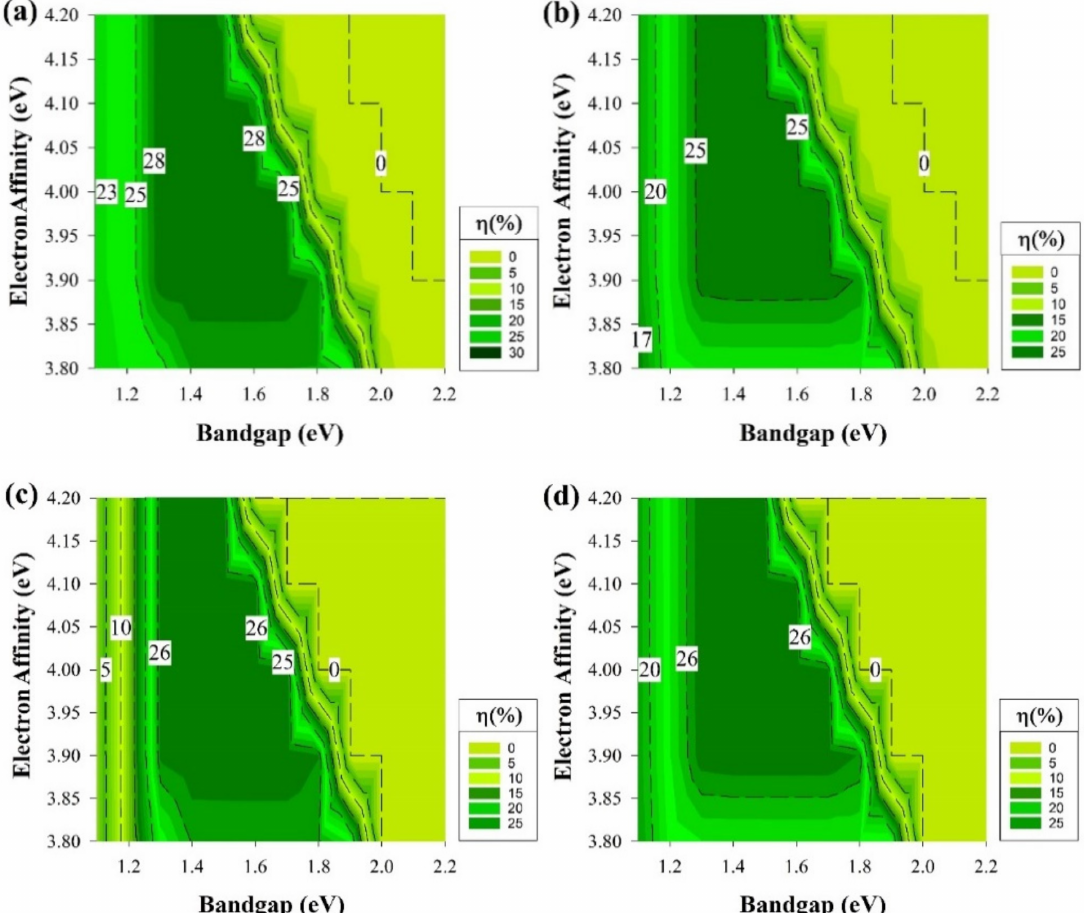
Figure 3. The efficiency of four proposed structures as a function of E g and χ for all passivating and doped layers without defects. ( a ) Contour graphs of the n-i-p structure with p-type wafer base. ( b ) Contour graphs of the n-i-p structure with n-type wafer base. ( c ) Contour graphs of the p-i-n structure with the p-type wafer. ( d ) Contour graphs of the p-i-n structure with n-type wafer base. The dead zone is always after 2 eV in the E g or at higher χ ( ≥ 4.1) when E g = 1.7